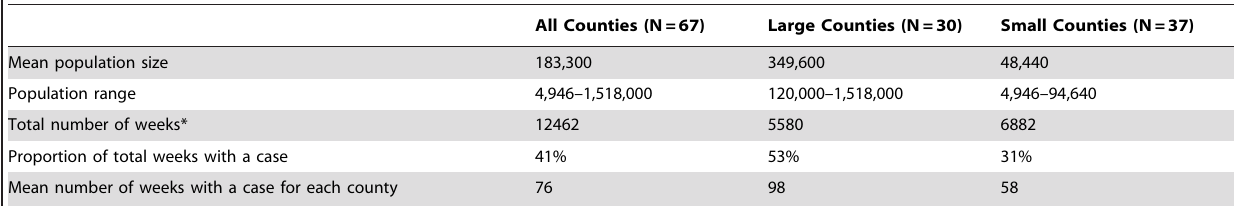
Table 1. County characteristics.